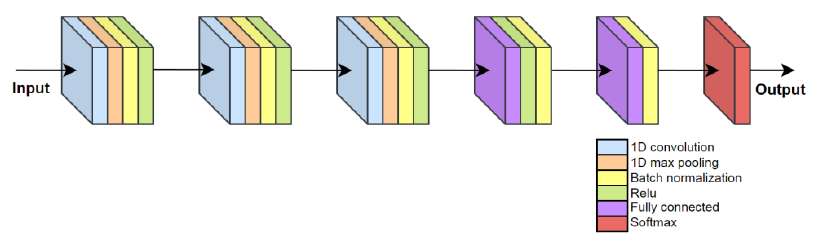
Figure 8. Visualization of the CNN + RNN algorithm architecture.